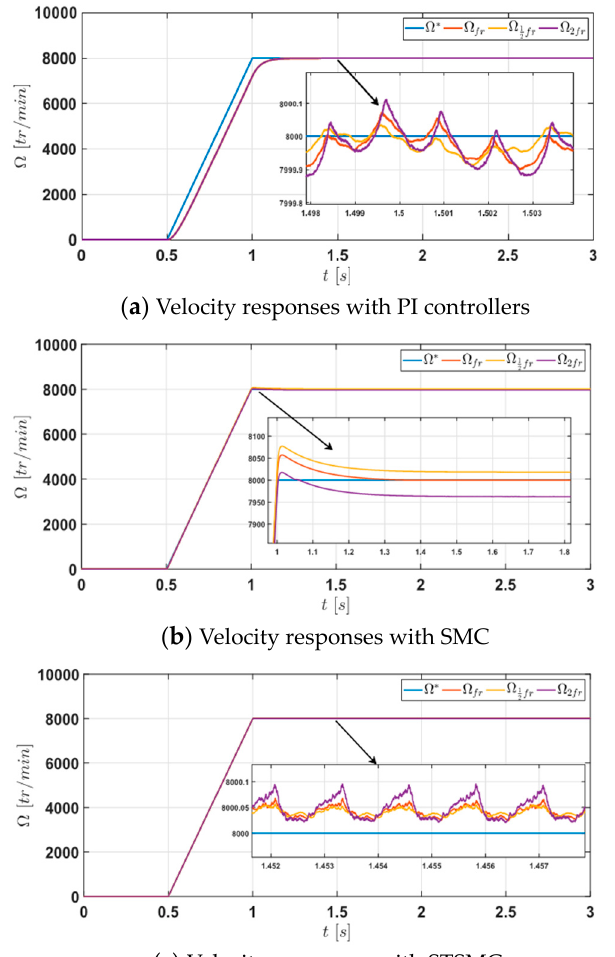
Figure 9. Velocity responses with the three controllers.